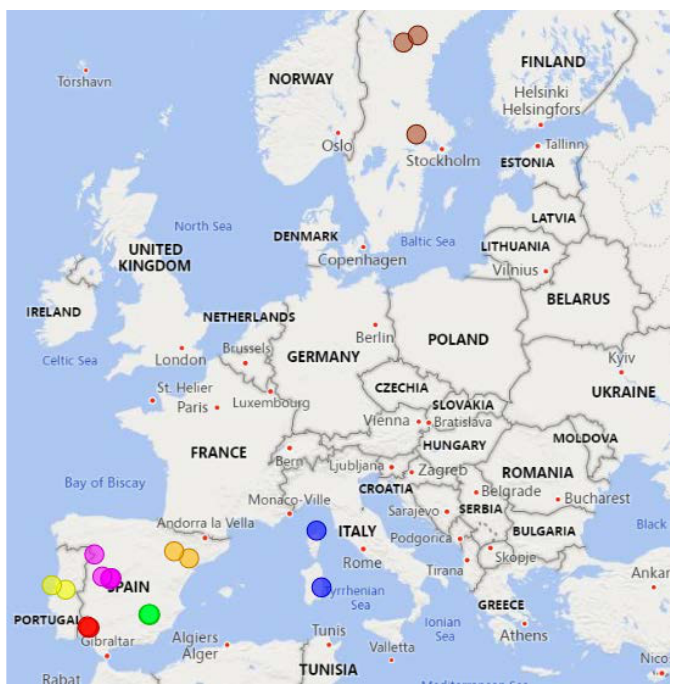
Figure 1. Map of the areas hit by wildfires considered in this study, split by fold. Circles determine the position of the considered wildfires, while each circle colour identifies a specific fold: circles of the same color identify areas of interest attributed to the same